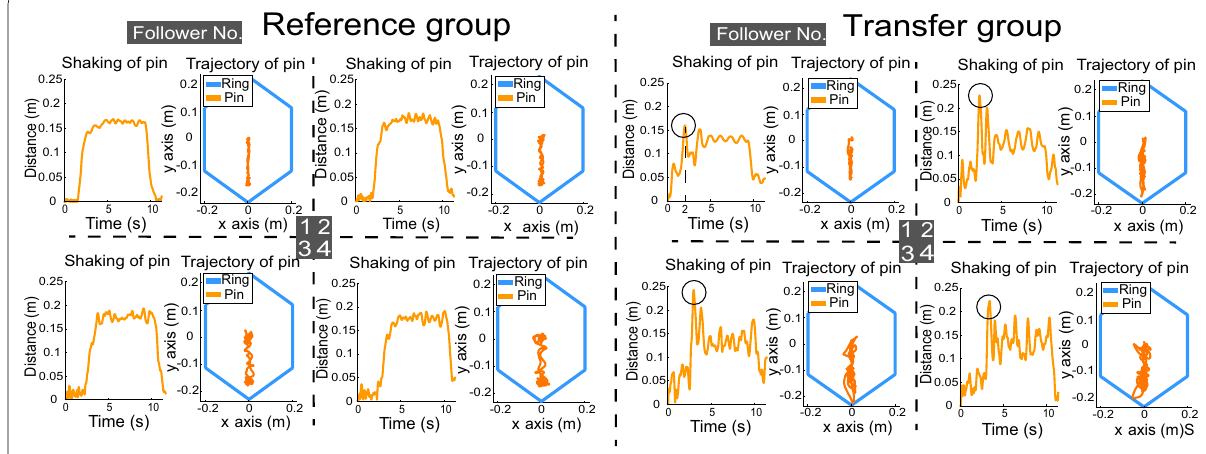
Sensor clustering using calculation range restriction Deciding calculation range on each position index From the output values L ( 1 ) - L ( 8 ) of the reference sen- sor group and the pin trajectory, distance d and tilt ϕ between the sensor and the measurement object (the ring wall of the relative position and orientation measurement device) were calculated at each position index, and then used as the calculation ranges of the normalized dis- tance. The result of the calculation range for each posi- tion index is shown in Fig. 15. “Unrestricted” illustrated by the arrows contains the range of minimum to maxi- mum values of the output distance d and tilt ϕ of all sen- sors equipped with the relative position and orientation measurement device during HILS. On the other hand, “Restricted” illustrated by the rectangles of each color contains the minimum to maximum range of the output distance d and tilt ϕ of the sensor attached to each posi- tion index shown as (1)–(8) in Figure 5 during HILS. It was found that distance d and tilt ϕ between the sensor and the object to be measured during platooning differed significantly depending on the position index. As the range used to calculate the normalized distance for each position index is different, it is expected that the normalized distance and clustering results will vary for each position index. In this section, normalized distance calculation and clustering are performed for each sensor position index. As shown in Fig. 15, when the calculation range of the normalized distance is not restricted, the